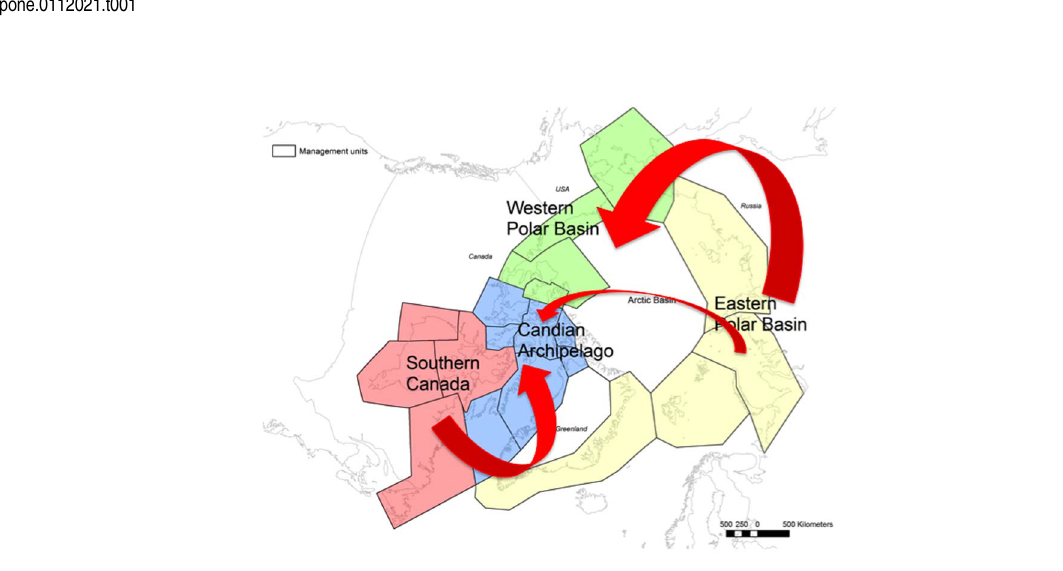
Fig 3. Recent directional gene flow (ca. 3–10 generations) calculated on the basis of allelic frequencies (number of migrants, m ) among polar bear clusters. Data generated using the program BAYESASS [47], examining gene flow relationships between the four clusters of polar bears (Southern Canada (SC; red), Canadian Archipelago (CA; blue), Eastern Polar Basin (EP; yellow) and Western Polar Basin (WP; green)), identified by program STRUCTURE analysis of microsatellite data. Arrow widths represent only directional gene flow values that are significantly different from zero (no migration) and from the value for migration in the opposite